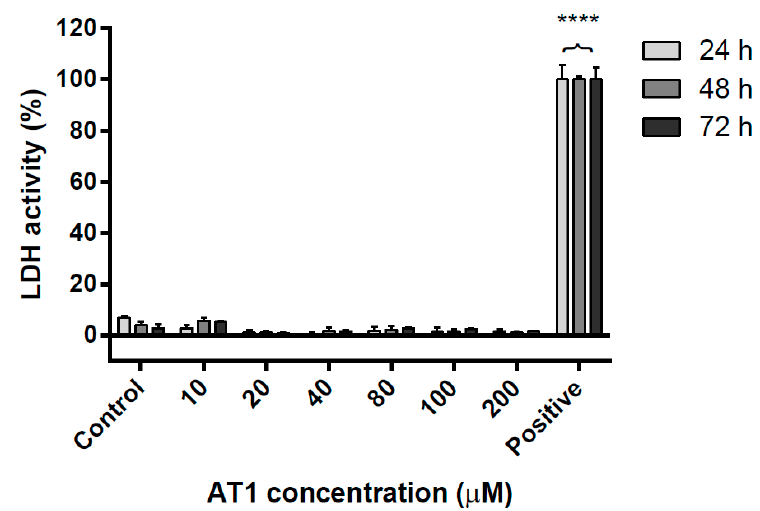
Figure 3. The necrotic effects of various AT-I concentrations on the HT-29 cell line, after treatment for 24, 48 and 72 h, as determined by LDH activity in cell culture medium. The control group was not treated with AT-I, showing little LDH activity. Data are shown as mean ± SD, n = 6. Significant differences are indicated by **** p < 0.0001 as compared with the control group.